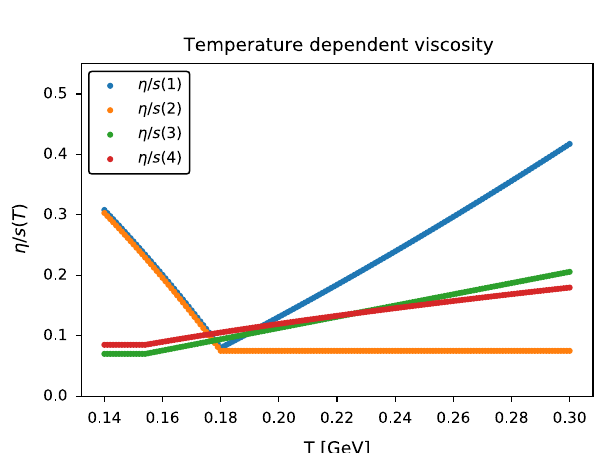
Fig. 5 Four temperature-dependent viscosities from Refs.